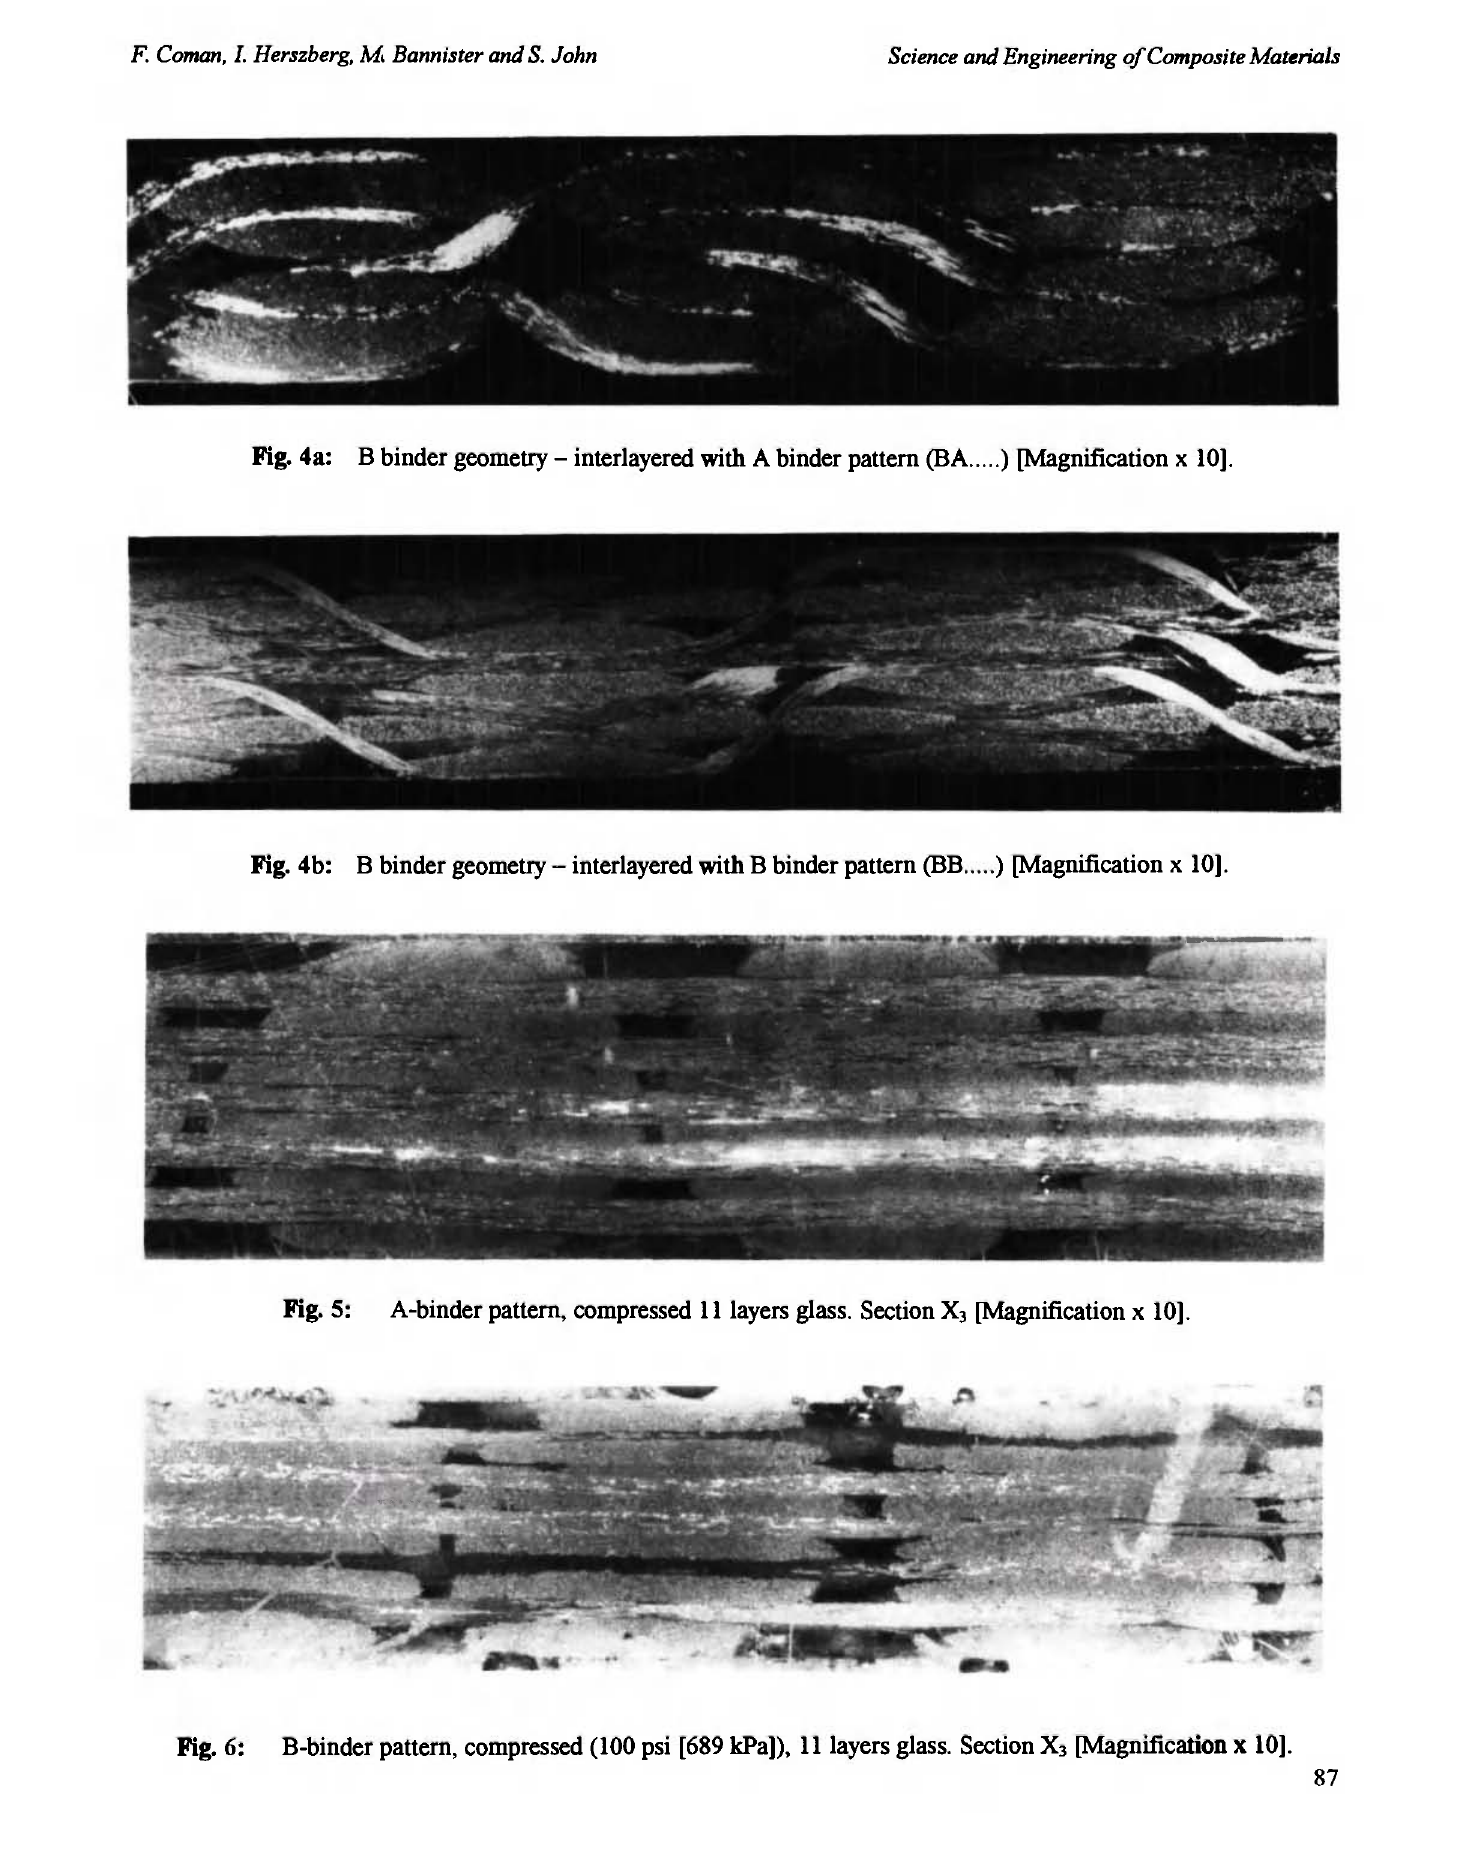
Fig. 6: B-binder pattern, compressed (100 psi [689 kPa]), 11 layers glass. Section X